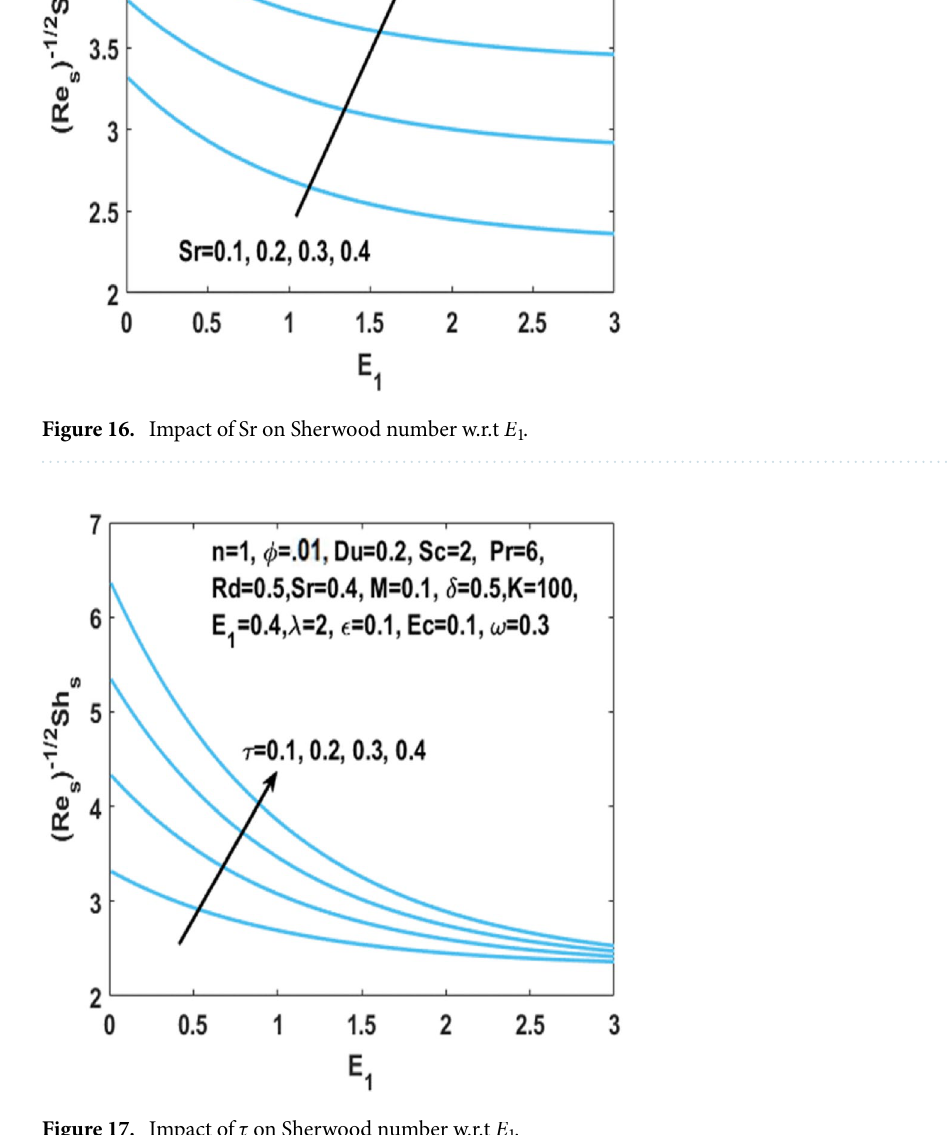
Figure 17. Impact of τ on Sherwood number w.r.t E 1